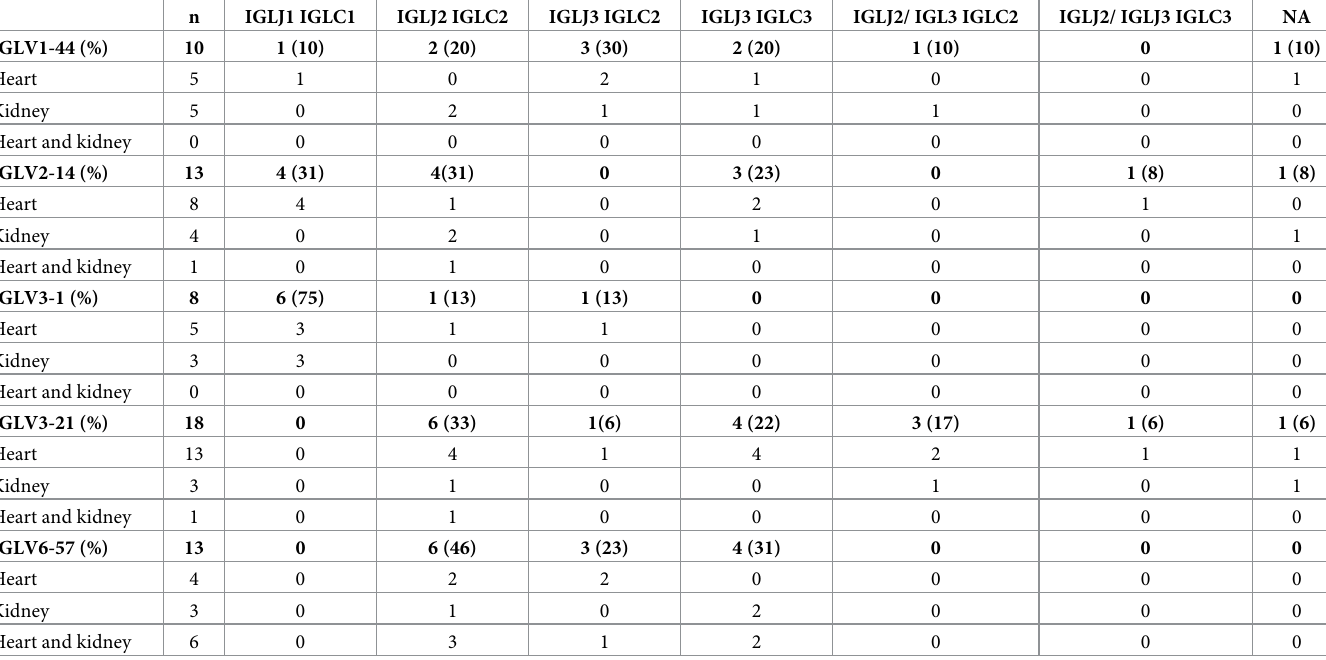
Table 4. Analysis of the usage of J λ germline und C λ germline repertoire depending on the used V λ germline.